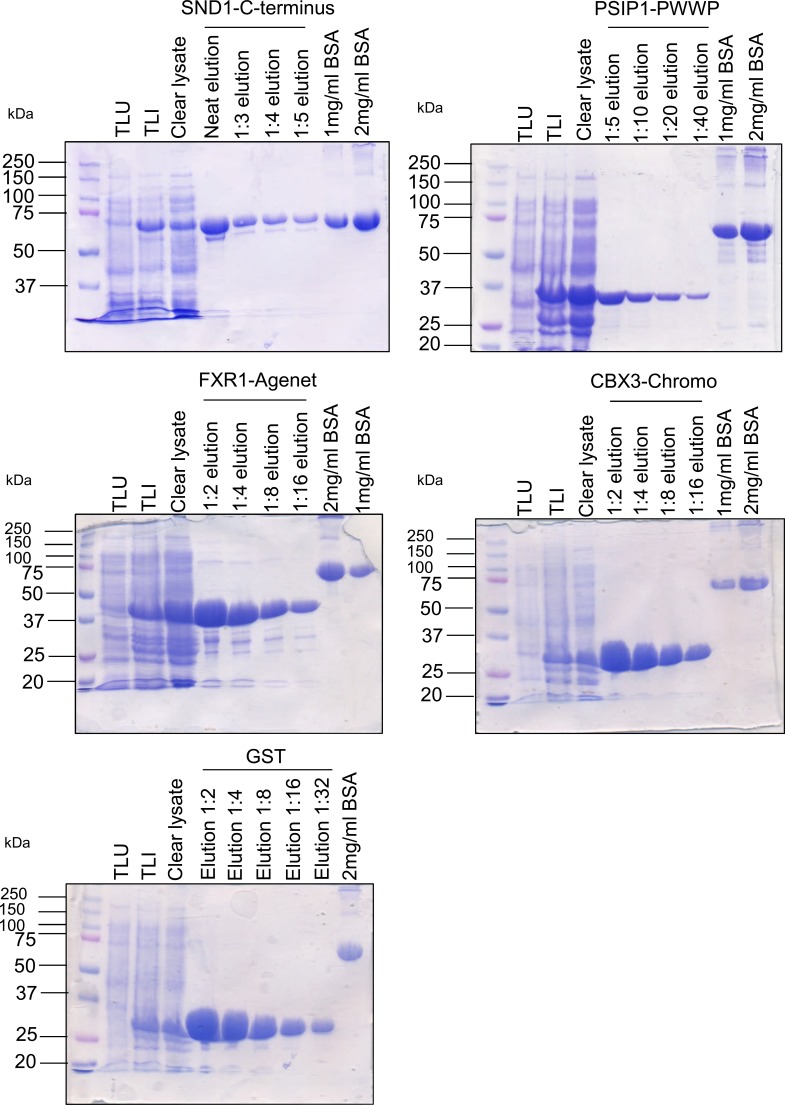
Representative coomassie-stained SDS-PAGE gels for all recombinant proteins used.TLU, total lysate from E. coli uninduced cells. TLI, total lysate from E.coli induced cells.